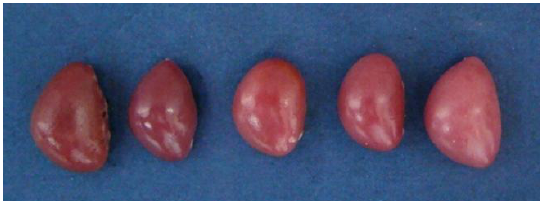
Figure 2. Gross changes in the size and colour of the spleen in the chickens at 21 days of age. From left to right: spleen in control group, 25%, 50%, 75% and 100% groups.